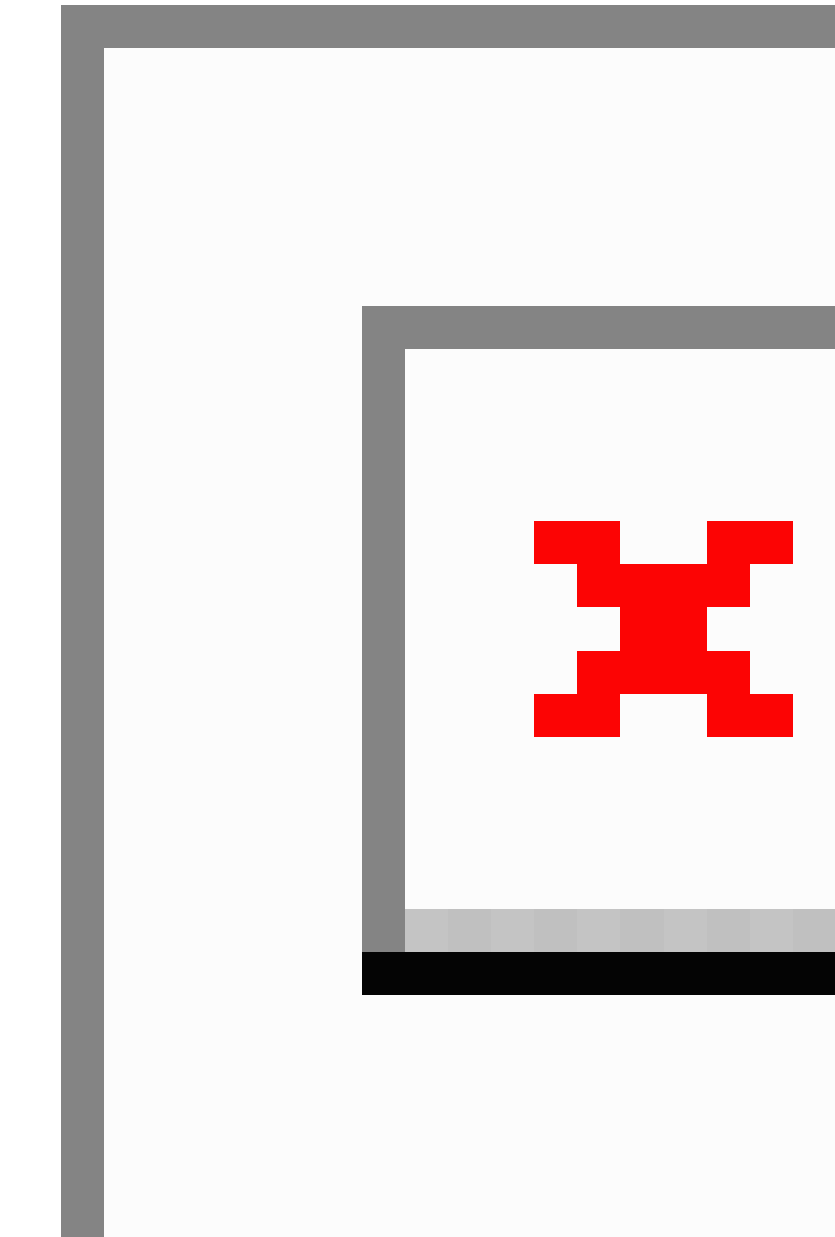
Figure 3. An example of white labeling where the apps have the same description but are labeled as different apps. The word depression (circled in red) is only one in a list of unrelated terms and is an example of how such lists allow non-depression apps to enter the